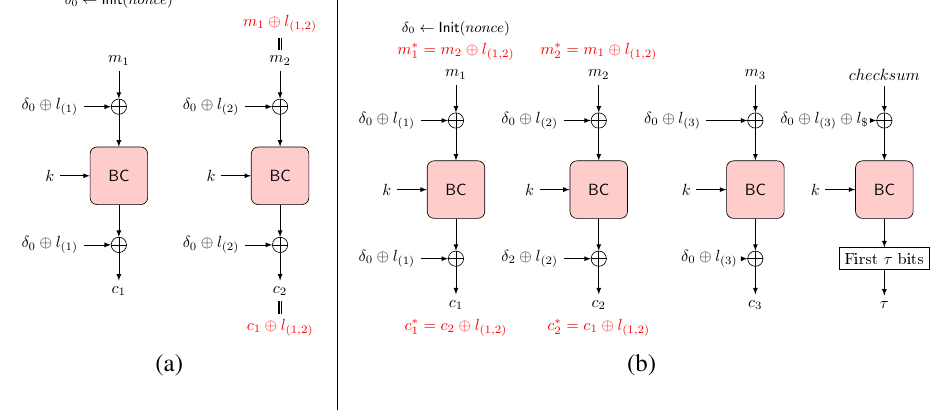
Figure 6: (a) Attack against confidentiality of OCB with side-channel leakage. The adversary asks the encryption of a message m = ( m 1 , m 2 , m 3 , ... ) with m 2 = m 1 ⊕ l 1 , 2 with a nonce nonce . She can distinguish c 2 from a random block. (b) Attack against authenticity of OCB with side-channel leakage. The adversary asks the encryption of a message m = ( m 1 , m 2 , m 3 ) with a nonce nonce , obtaining c = ( c 1 , c 2 , c 3 , τ ). She can output ( nonce , c ∗ ) with c ∗ = ( c ∗